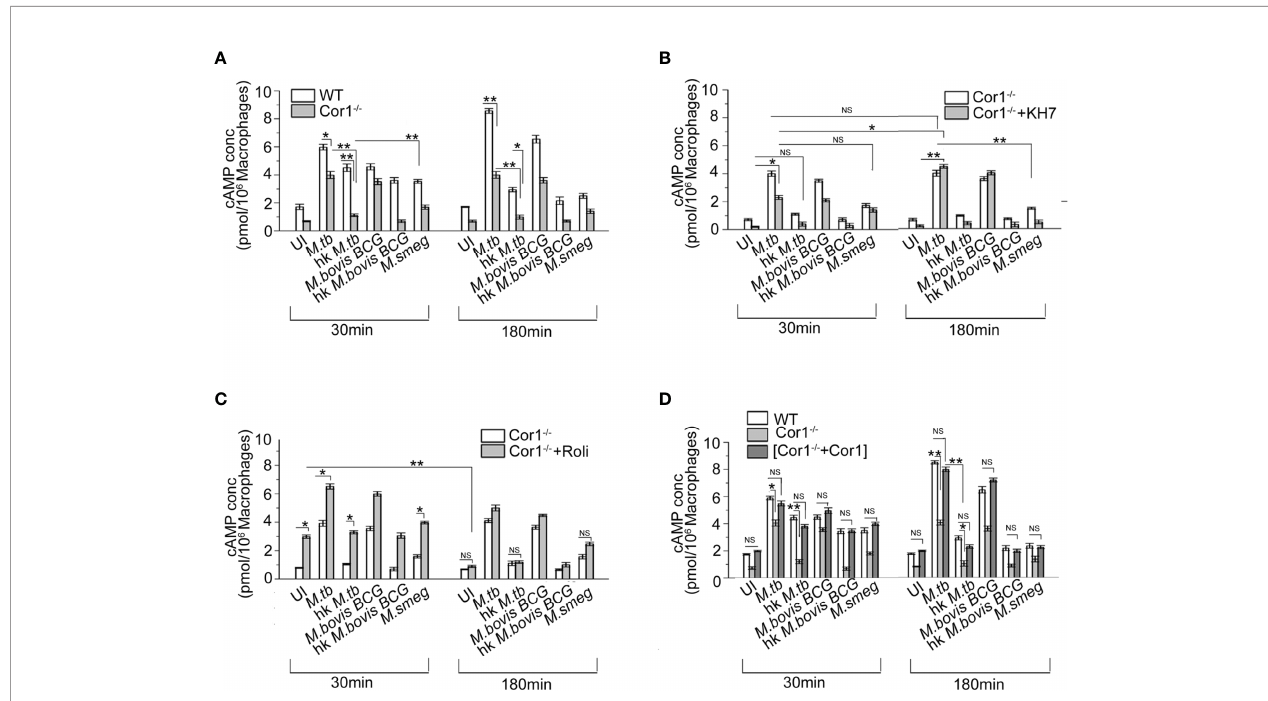
FIGURE 2 | Competitive ELISA-based measurement of intracellular cAMP concentration in uninfected and live M. tb , live M. bovis BCG , live M. smeg , heat-killed M. tb , and heat-killed M. bovis BCG infected (A) WT and Cor1 -/- BMDM, (B) Cor1 -/- BMDM without or after pretreatment with adenylate cyclase inhibitor KH7, and (C) Cor1 -/- BMDM without or after pretreatment with phosphodiesterase inhibitor Roliparm or (D) transfected with pCMV6-Coronin1 for indicated time points (n = 3). Data represents mean ± SEM; * p < 0.05, ** p < 0.01, NS, non-signi fi